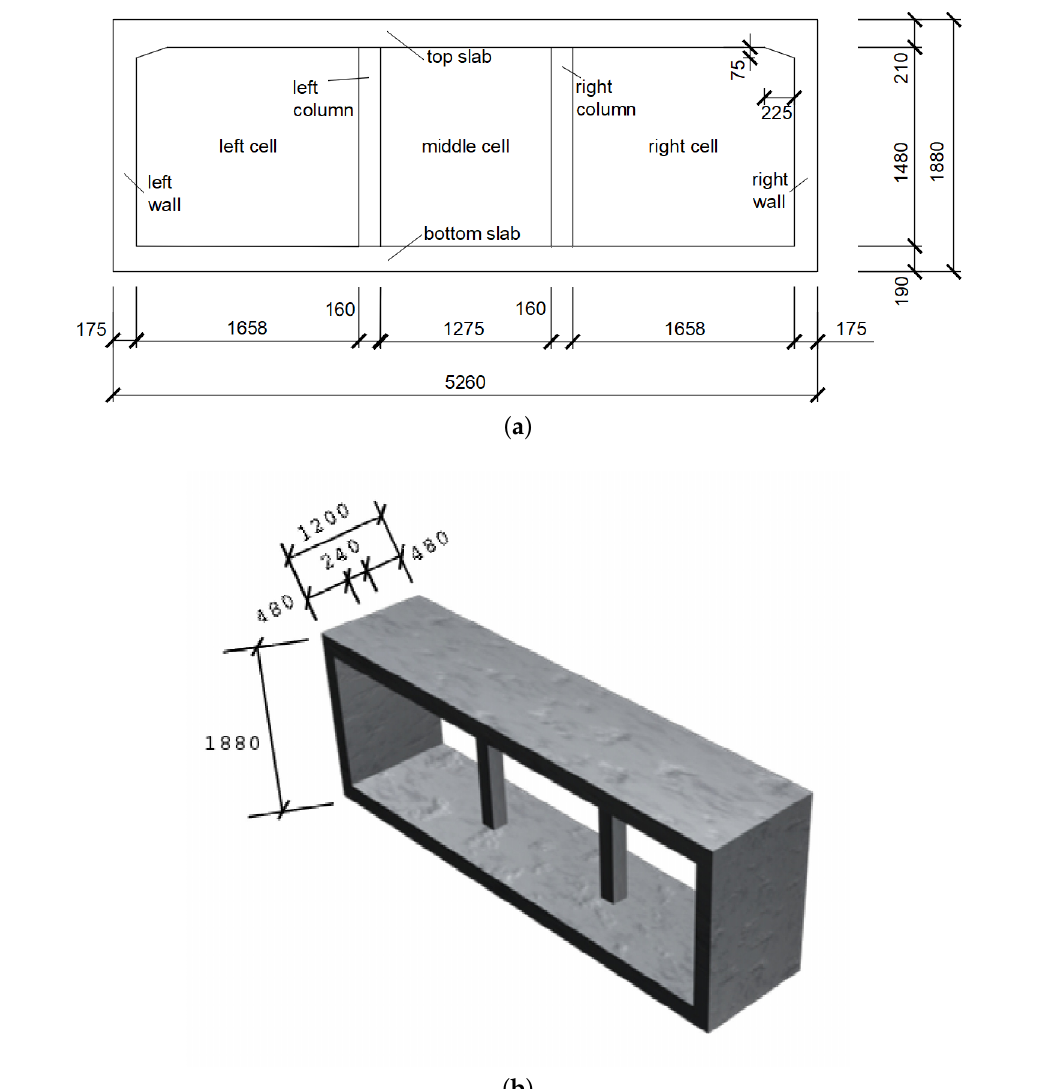
Figure 3. Geometric dimensions of the tested structure (mm): ( a ) cross-section and ( b ) perspective representation; adapted from